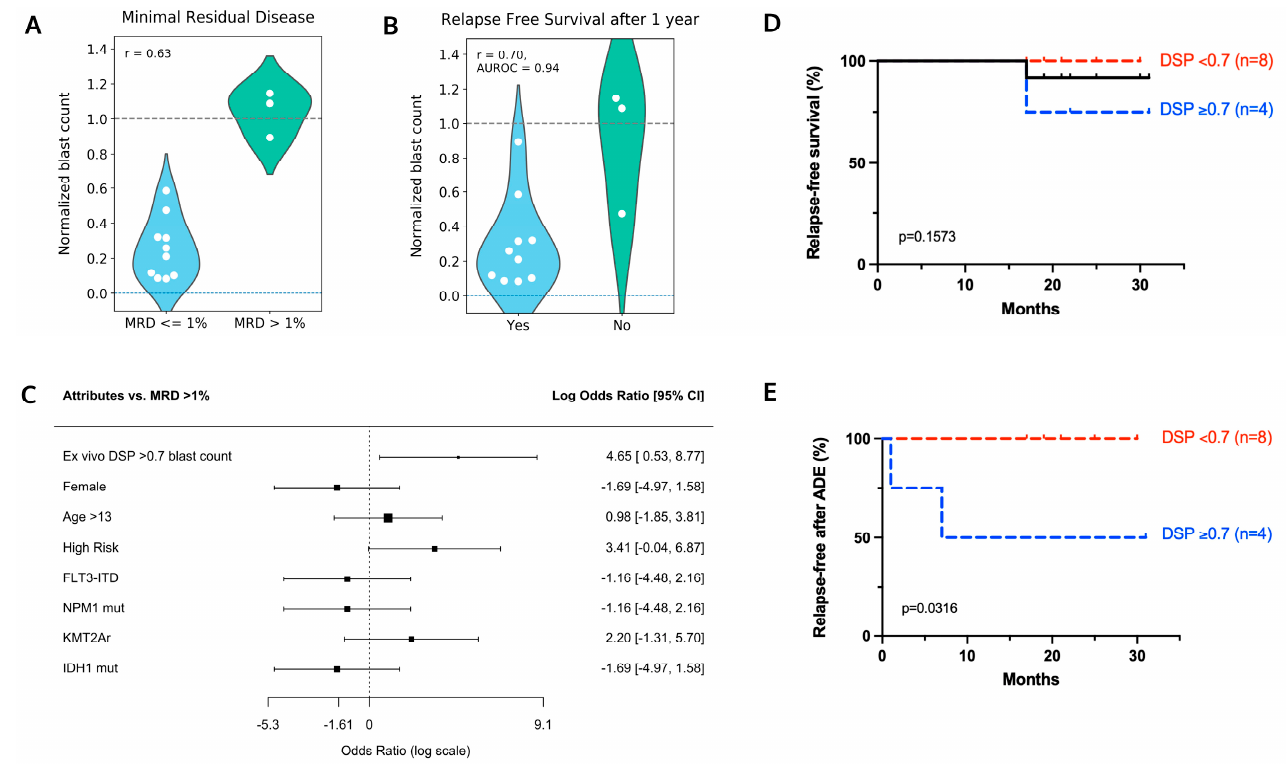
Figure 2. Ex vivo drug sensitivity to ADE correlates with clinical response. Diagnostic samples from 13 de novo pediatric AML patients that received ADE were screened for ADE sensitivity ex vivo. Violin plots to measure the correlation between normalized blast counts in the DSP and ( A ) minimal residual disease and ( B ) one year relapse-free survival. Lower dashed line at y = 0 indicates no blasts remaining following treatment with the drug. Upper dashed line at 1.0 indicates blast counts were comparable to the DMSO control. AUROC, Area Under the Receiver Operating Characteristic curve. ( C ) Log odds ratio comparing MRD > 1% with a single mutational or clinical attribute (rows). Black boxes indicate the log odds ratio on a log scale, with the size of the box being proportional to the number of patient samples. ( D ) Relapse-free survival curves and ( E ) incidence of relapse following induction for 12 patients treated with ADE. One patient died from treatment-related mortality and is excluded from this analysis cohort. Patients were stratified into two DSP groups based on high sensitivity to ADE ex vivo (DSP < 0.7; red) and low sensitivity to ADE ex vivo (DSP >= 0.7; blue). p - values were determined using the Log-rank (Mantel-Cox) test.